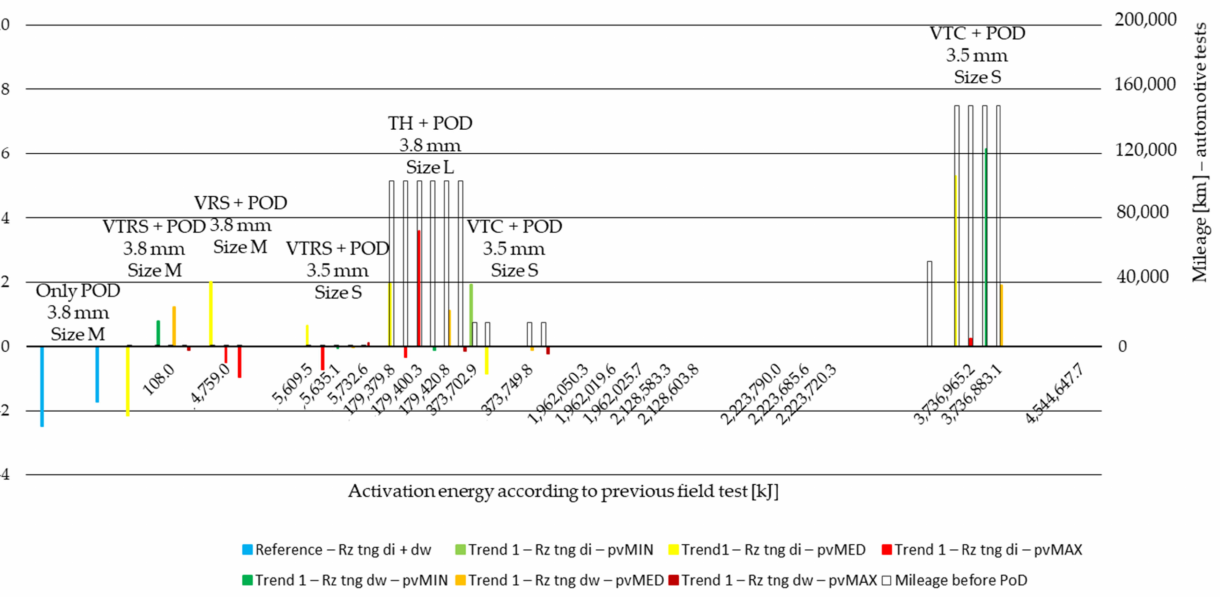
Figure A5. Tangential direction PoD specific Rz difference values of cut material samples from inner and working diameter after minimum, medium and maximum pv level pin-on-disc tests with previous field-test (Table 2) mileage along Joule scale—Trend 1: clutch killer load